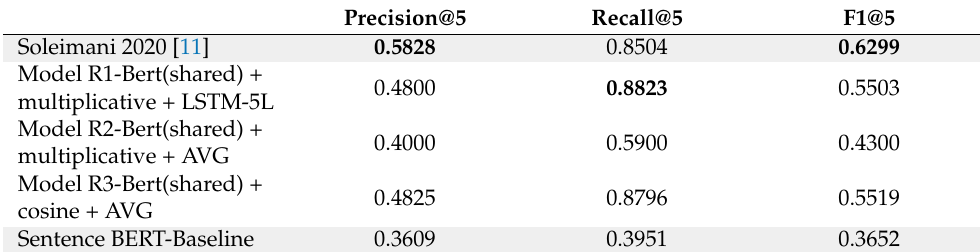
Table 2. Relevance classification results with a retrieval window of 5